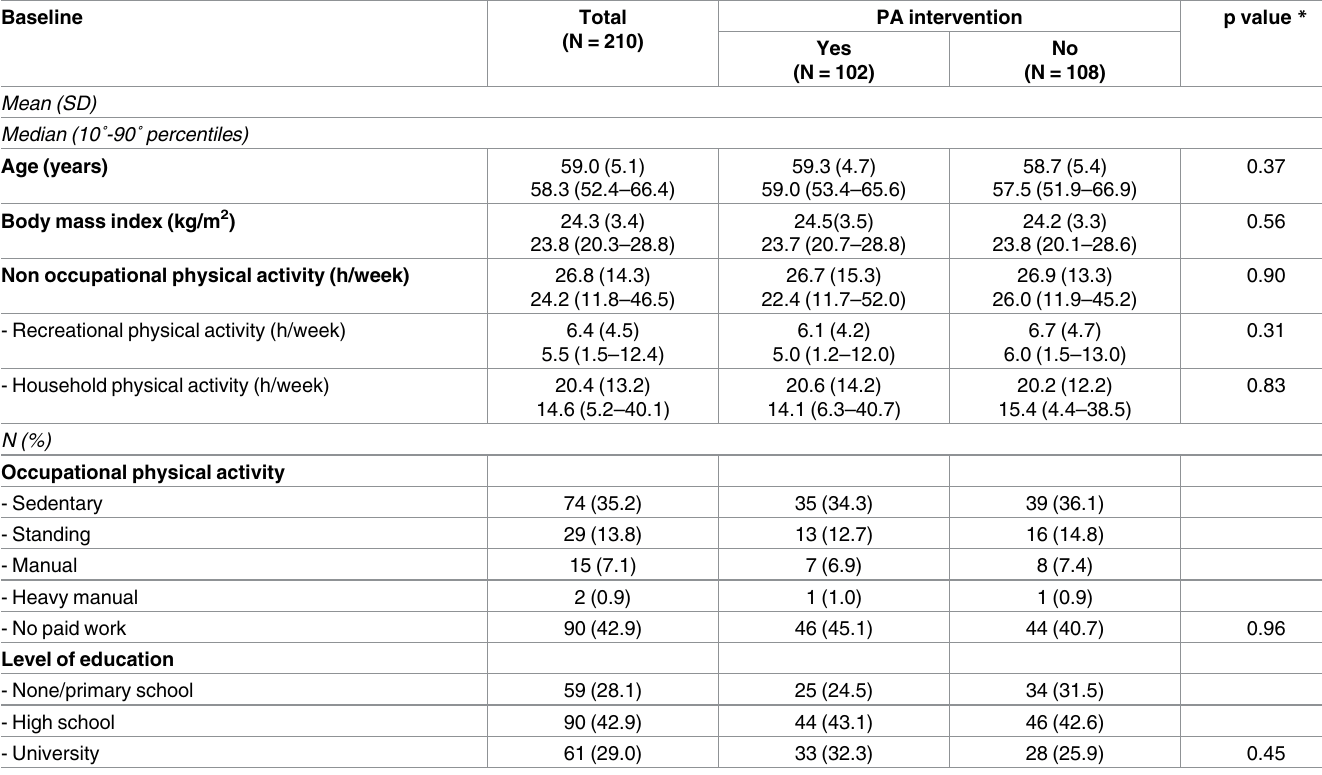
Table 1. Baseline characteristics of the study participants overall and according to physical activity (PA) intervention.